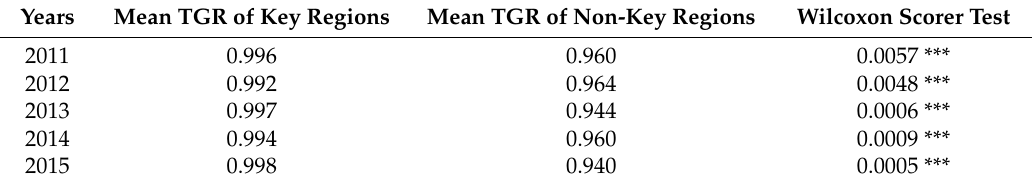
Table 4. Wilcoxon scorer test of technical efficiency